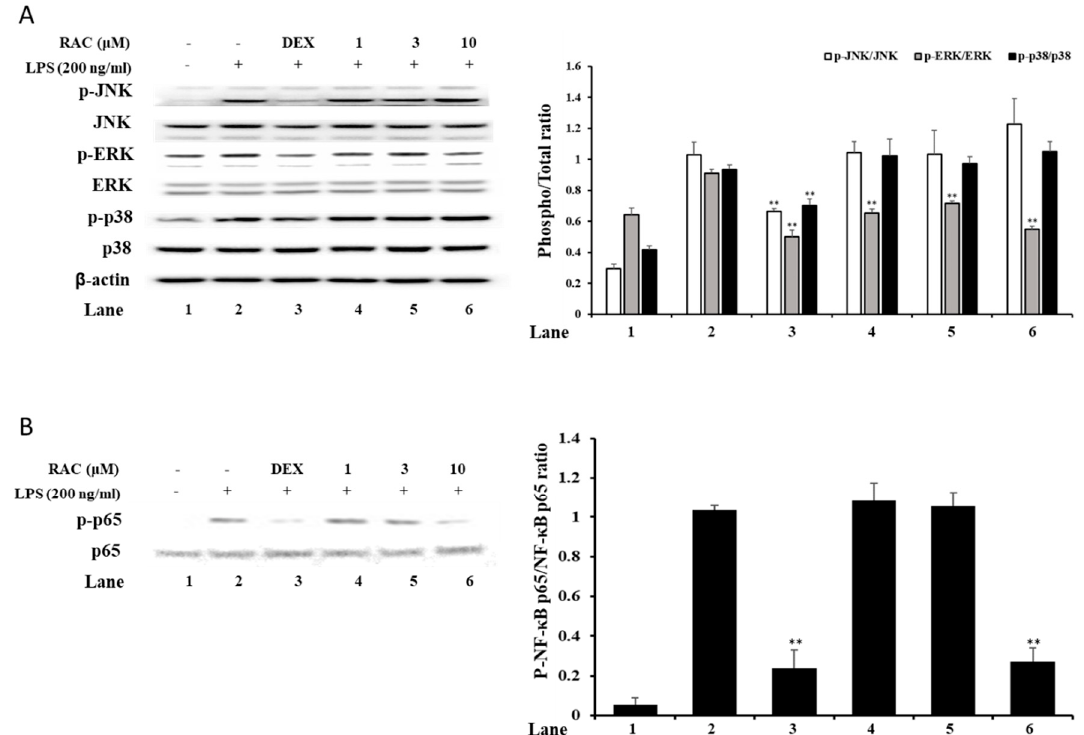
Figure 3. Effect of RAC on LPS-induced MAPKs and the NF- κ B signaling pathway. J774A.1 cells were pretreated with 10 μ M dexamethasone or 1, 3 or 10 μ M RAC for 1 h before treatment with 200 ng/mL LPS for 30 min to 1 h. ( A ) The protein expression of MAPKs was determined by immunoblot. Band optical densities were calculated by ImageJ software. ( B ) NF- κ B p65 subunit expression was measured by immunoblot analysis, and the band optical density was calculated by ImageJ software. The results are representative of three independent experiments. Values are presented as the mean ± SD of three individual experiments. * p < 0.05, ** p < 0.01 compared with the LPS only-treated group.